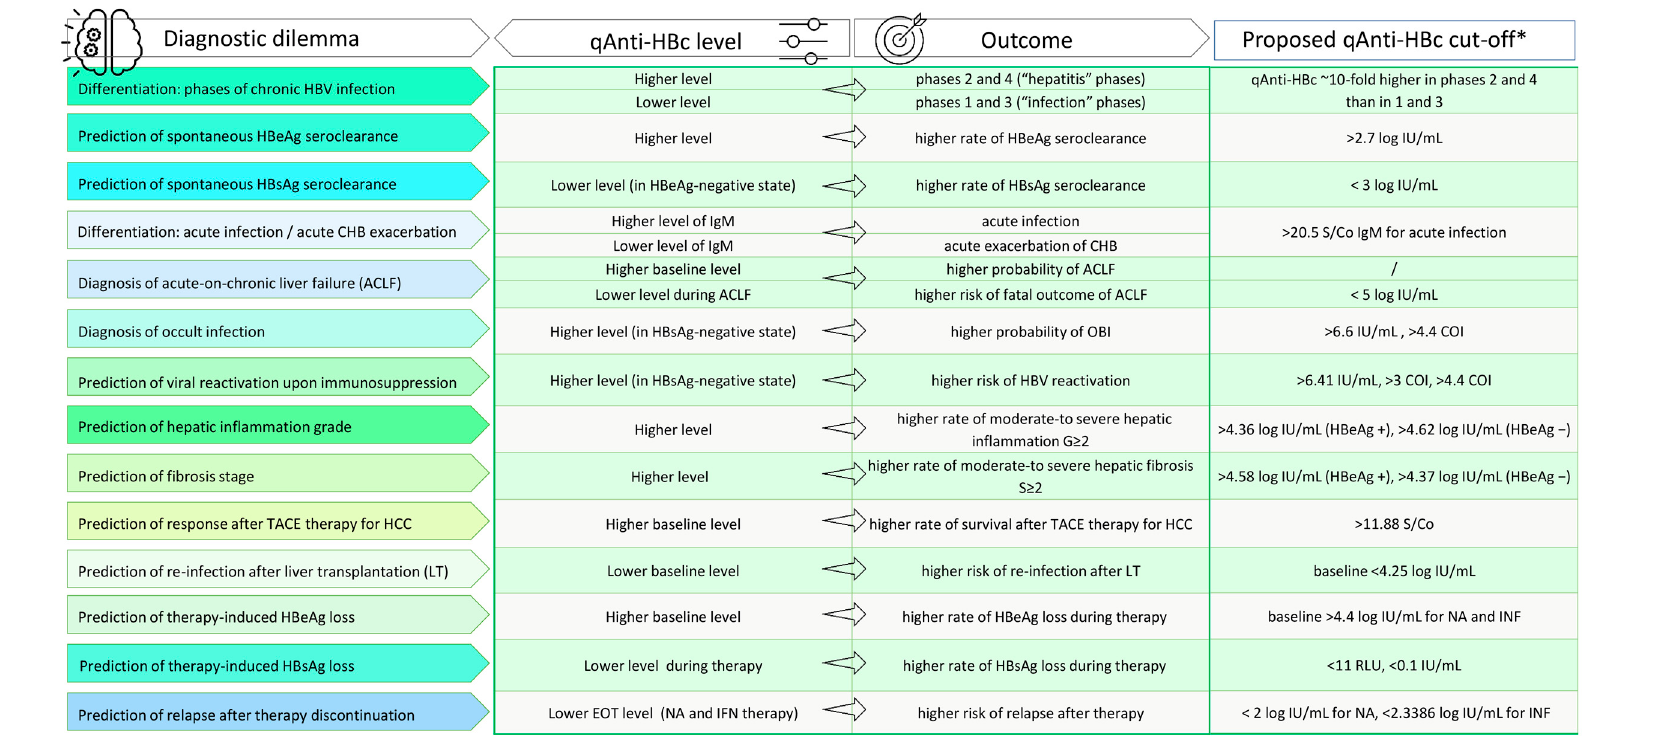
Figure 2. The significant findings on the clinical utility of qAnti-HBc; * the cut-off values vary significantly among studies, one or two are listed for each diagnostic problem; qAnti-HBc: quantitative HBV core antibodies; CHB: chronic hepatitis B; ACLF: acute-on-chronic liver failure; OBI: occult HBV infection; TACE: transarterial chemoembolisation; HCC: hepatocellular carcinoma; LT: liver transplantation; EOT: end-of-treatment; NA: nucleos(t)ide analogue; IFN: interferon; IU: international units; COI: cut-off index; S/Co: sample/cut-off; References associated with diagnostic problems: Refs. [18,26–30] (differentiation of phases of CHB infection), refs. [31,32] (prediction of spontaneous HBeAg seroclearance), refs. [33,34] (prediction of spontaneous HBsAg seroclearance), ref. [35] (differentiation between acute infection and acute CHB exacerbation), ref. [36] (diagnosis of acute-on-chronic liver failure), refs. [20,27,28,37,38] (diagnosis of OBI), refs. [21,37,39,40] (prediction of viral reactivation upon immunosuppression), refs. [19,41–49] (prediction of hepatic inflammation grade), refs. [50–53] (prediction of fibrosis stage), ref. [54] (prediction of response after TACE therapy for HCC), ref. [55] (prediction of re-infection after LT), refs. [23,56–63] (prediction of therapy-induced HBeAg loss), refs. [64–67] (prediction of therapy-induced HBsAg loss), refs. [68–71] (prediction of relapse after therapy